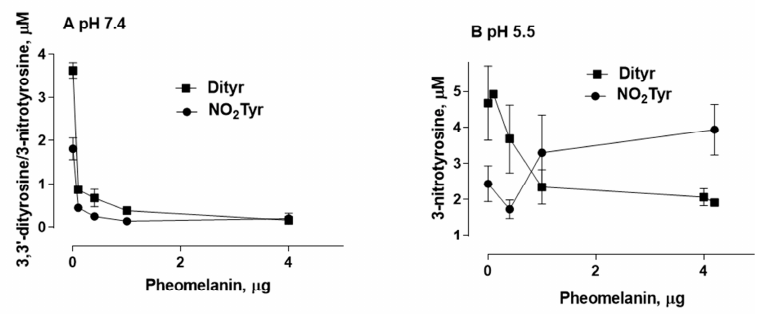
Figure 5. Photooxidation of tyrosine by the nitrite/pheomelanin/UVB system at various synthetic pheomelanin concentrations. Pheomelanin (0.1–4 μ g/mL) is added to a reaction mixture containing 1 mM tyrosine, 10 mM K-nitrite, 0.1 mM DTPA in 0.2 M K-phosphate buffer at pH 7.4 ( A ) or pH 5.5 ( B ). The solution is exposed to UVB rays for 30 min. The reaction is stopped by placing the mixture in the dark and the supernatant, obtained after centrifugation, is analyzed by HPLC to determine the formation of 3-nitrotyrosine ( ● ) and 3,3 ′ -dityrosine ( ■ ) as reported in Materials and Methods.